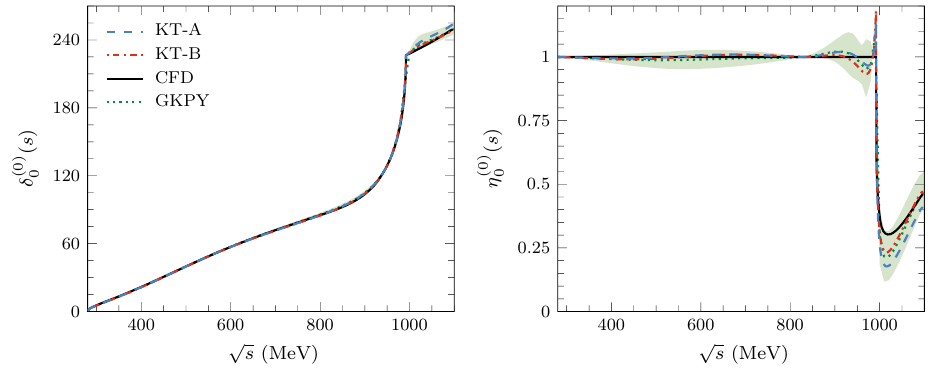
Fig. 3 Phase shift (left) and inelasticity (right) for the S 0 wave. The notation for the different curves and the band is as in Fig. 2. These quan- tities are constructed from the real and imaginary parts of the S 0 partial wave. The real part of the KT or GKPY amplitudes is given by the